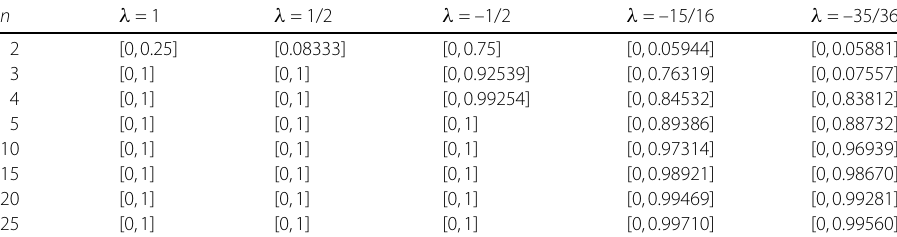
Table 2 The intervals where B n , λ ( t 2 ; x ) is convex for the corresponding values of λ and